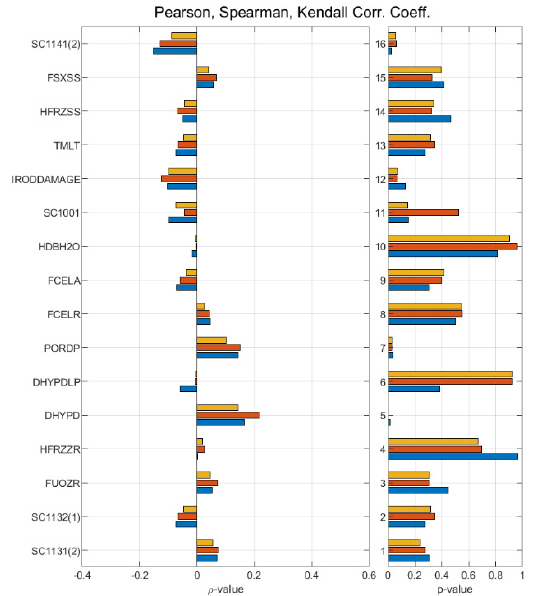
Figure 13. Pearson (yellow), Spearman (red), and Kendall (blue) correlation coefficients for FPT model; H 2 production (final core state) vs. uncertainty parameters. Values for IRODDAMAGE and SC1001 have no meaning.